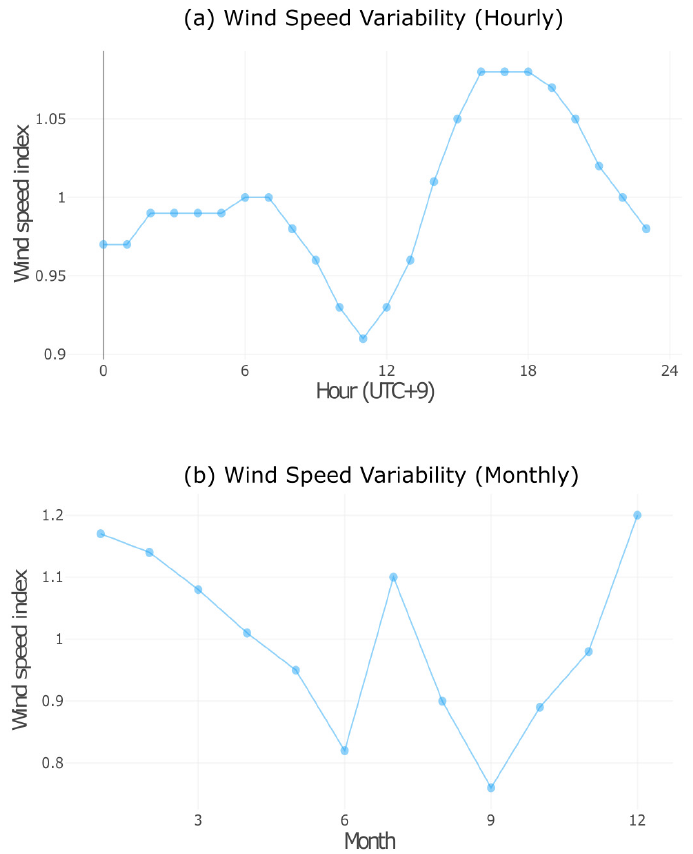
Figure 7. Global Wind Atlas: Wind speed